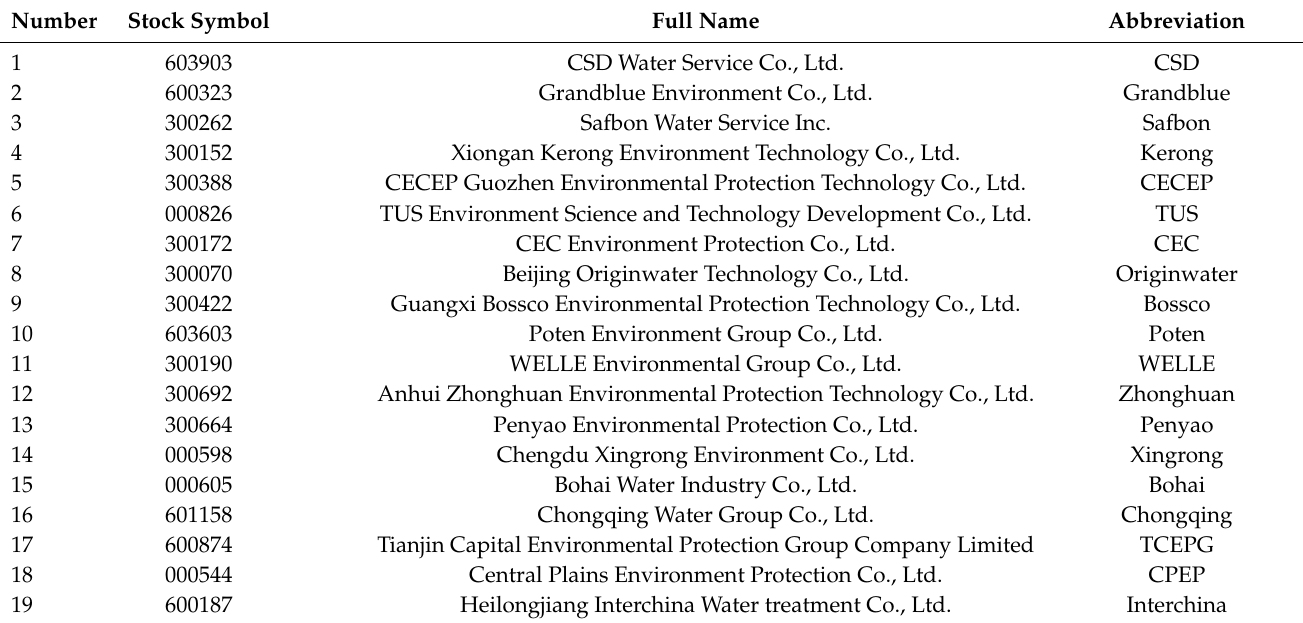
Table 1. Sample of listed wastewater